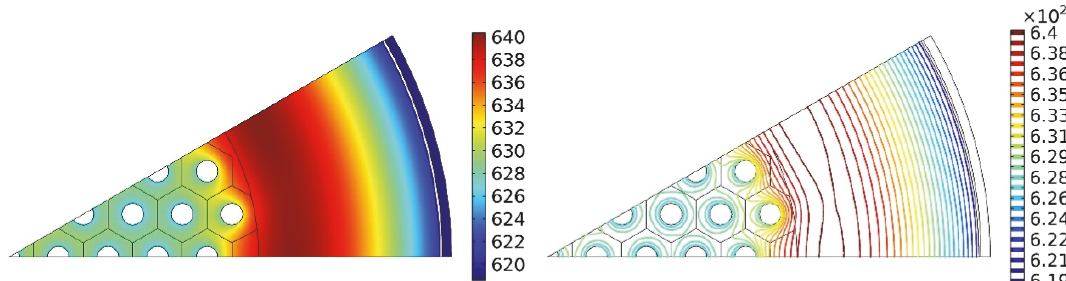
Figure 8: The cross-sectional view of temperature field (left) and isotherms (right) in the solid region near the outlet (z=1.0m) (unit: ∘ C).